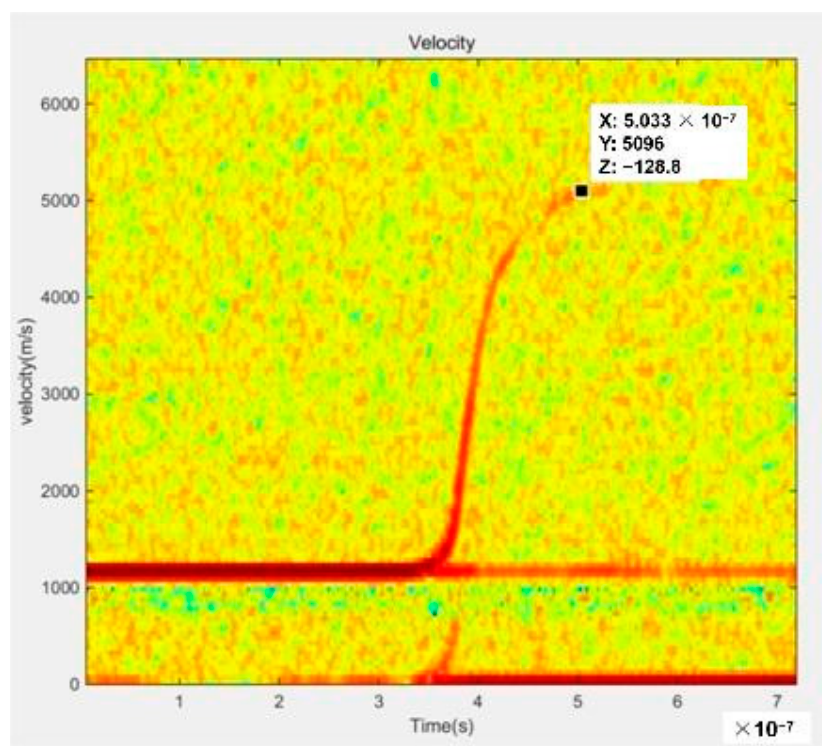
Figure 5. PDV spectrogram of the flyer with a working voltage of 4000 V.